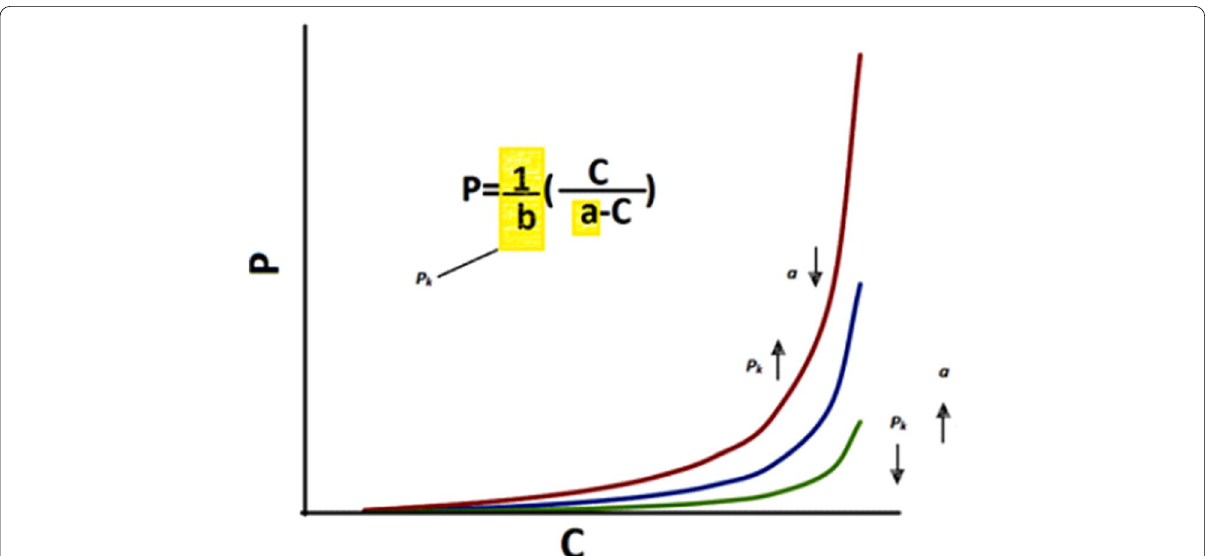
Fig. 10 A sketch representing the effect of changing Kawakita parameters ( P k and a ) on the position of the F-D curve in accord with Eq. 2 when there is no remarkable difference in maximum volume reduction values between non-compacted and compacted powders